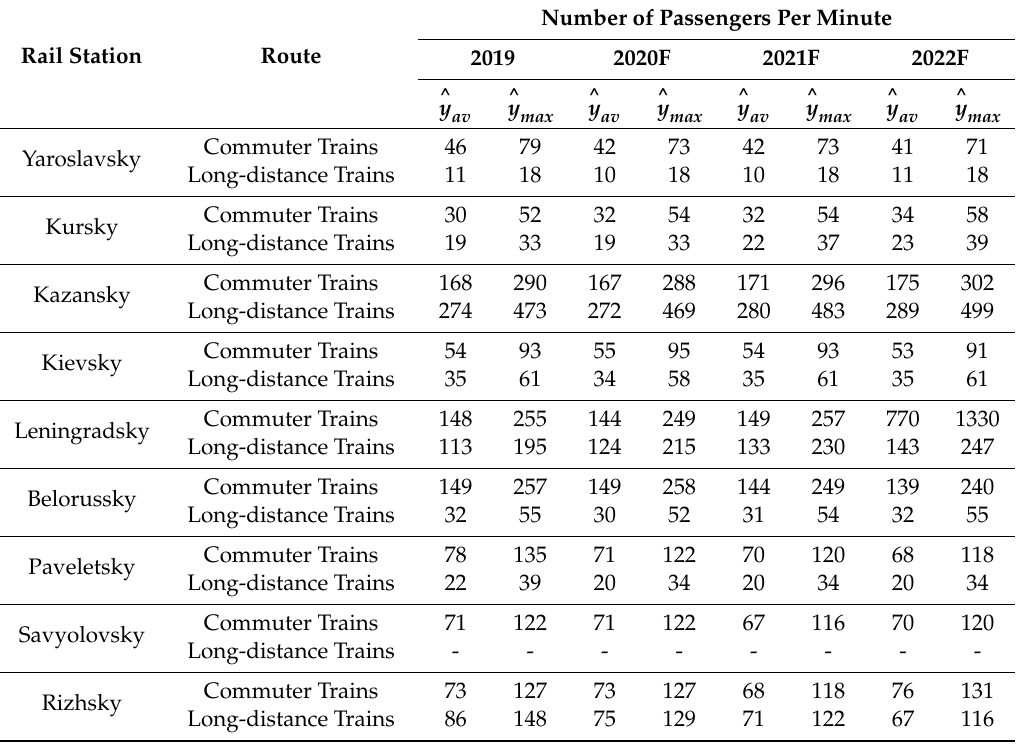
Table 4. The average annual and maximum flow for commuter trains and long-distance trains (F—forecast values).